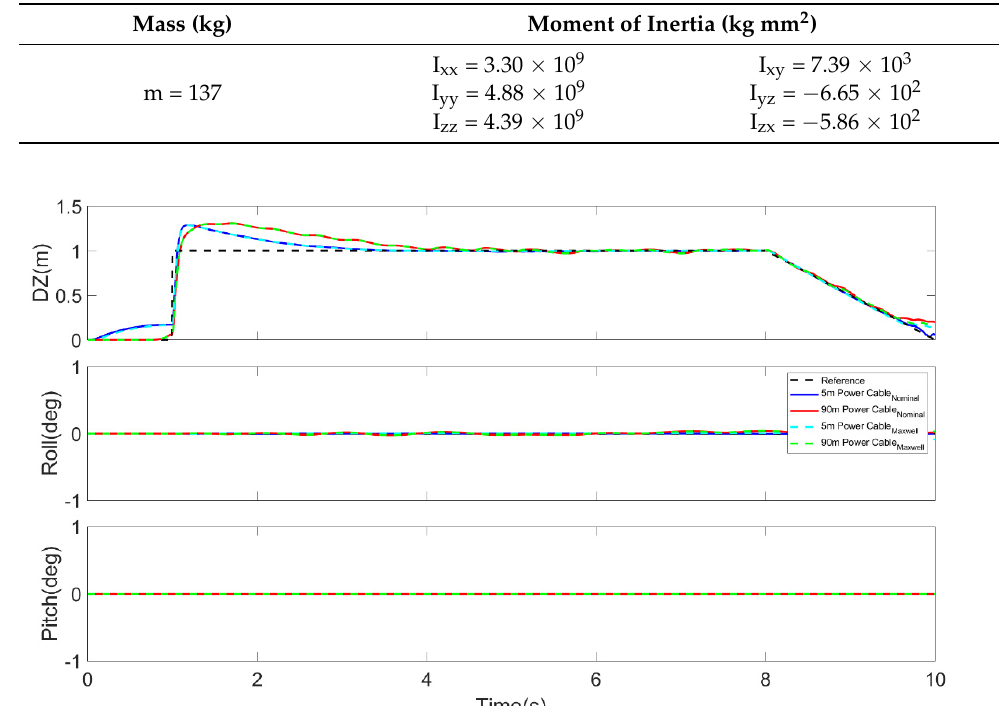
Figure 13. Position and attitude control simulation of the heavy-lift tethered multicopter: ( a ) Flexible multi-body dynamics model; ( b ) Block diagram for height and attitude control simulation. Table 7. Mass and moment of inertia of the heavy-lift multicopter without electric power cable.